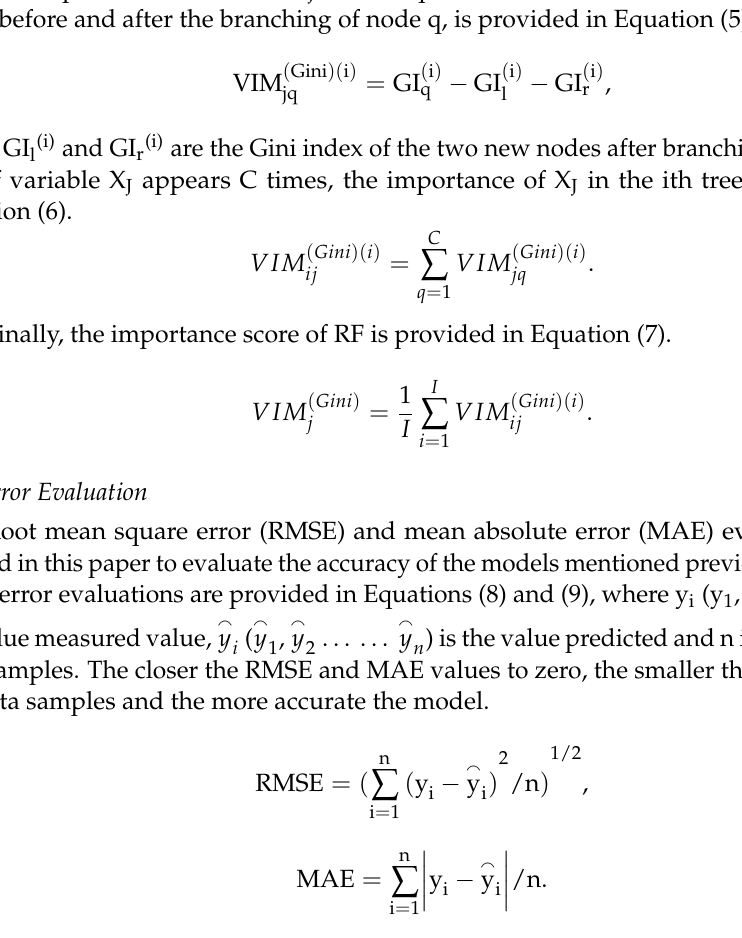
Figure 4. RF model Figure 4. RF model structure.